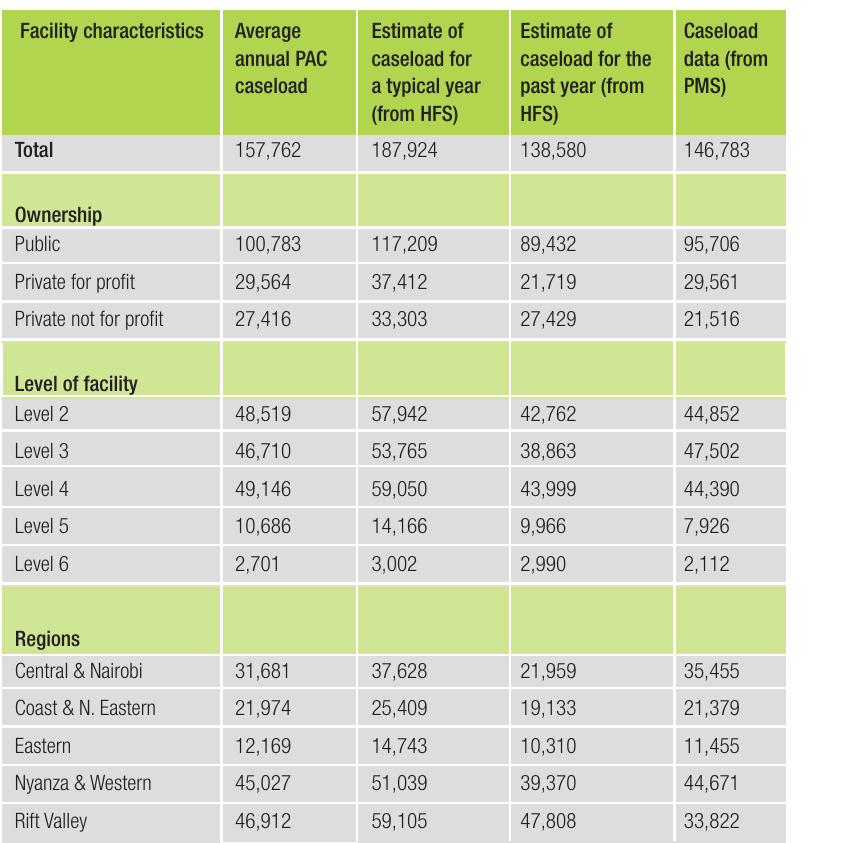
Estimated number of women treated annually for PAC by ownership, level of facility and region, Kenya, 2012 Facility